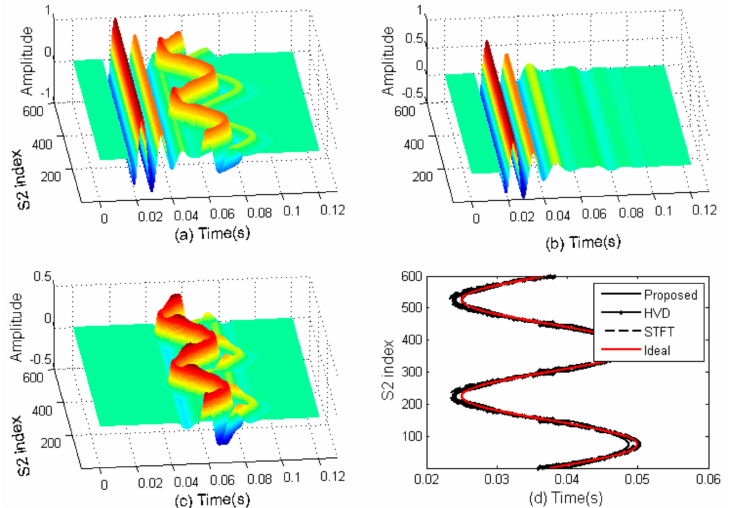
Figure 10. Validation by computer simulation. ( a ) Simulated S2 signals with varying split, ( b ) Extracted aortic components, ( c ) Extracted pulmonary components, ( d ) Comparison between the true splits and measured